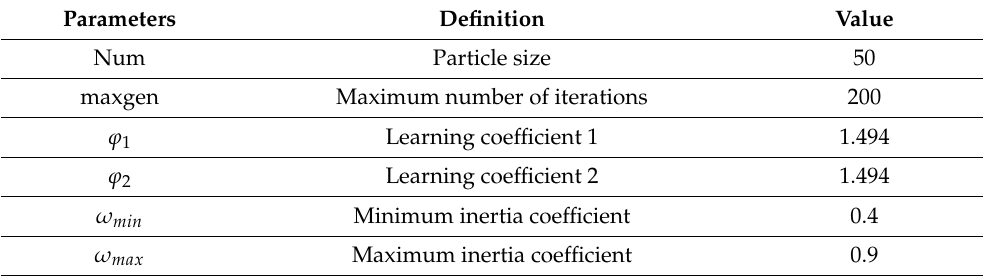
Table 11. Parameters of PSO